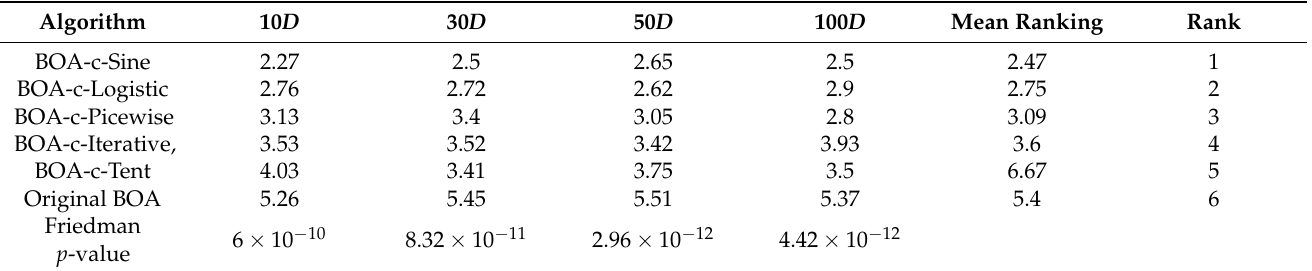
Table 1. Summary of the statistical findings of the Friedman test comparing the performance of the five chaos-improved BOA algorithms and the conventional BOA